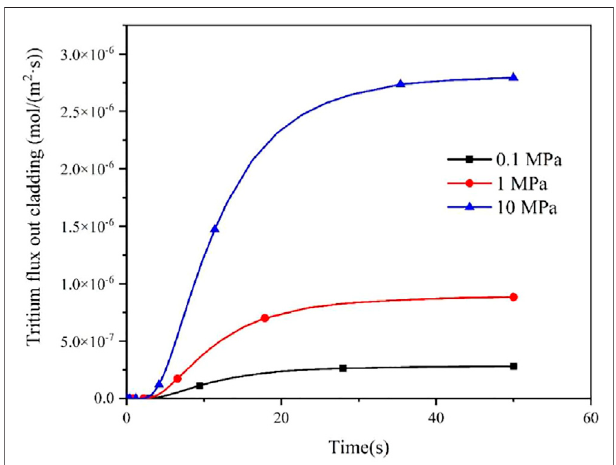
FIGURE 7 | Effect of different fuel rod internal pressures on tritium fl ux rates on the cladding outer surface.